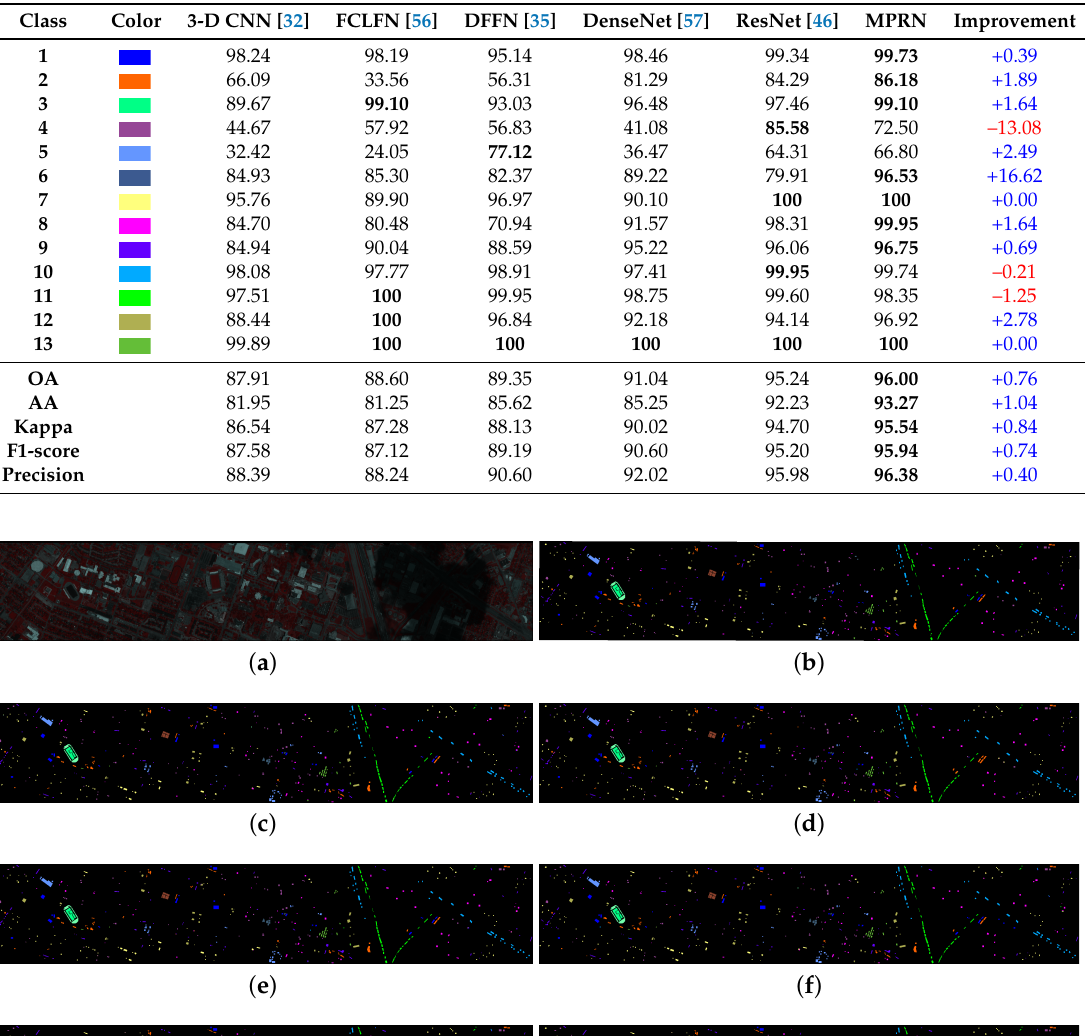
Classification accuracies (%) obtained by different methods on the KSC data set. The improvement of MPRN over ResNet is also provided. The best results are highlighted in bold font. In addition, the positive and negative improvements are marked in blue and red, respectively.